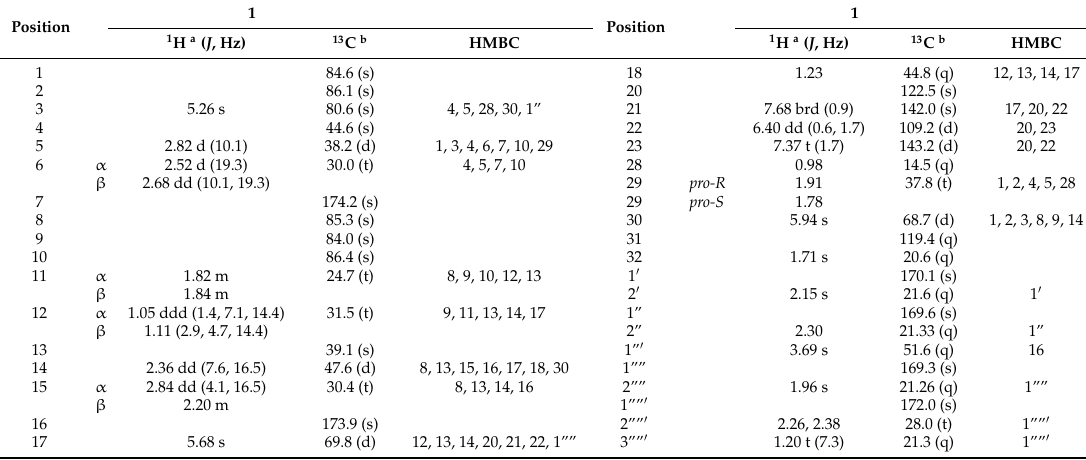
a Measured at 600 MHz in CDCl